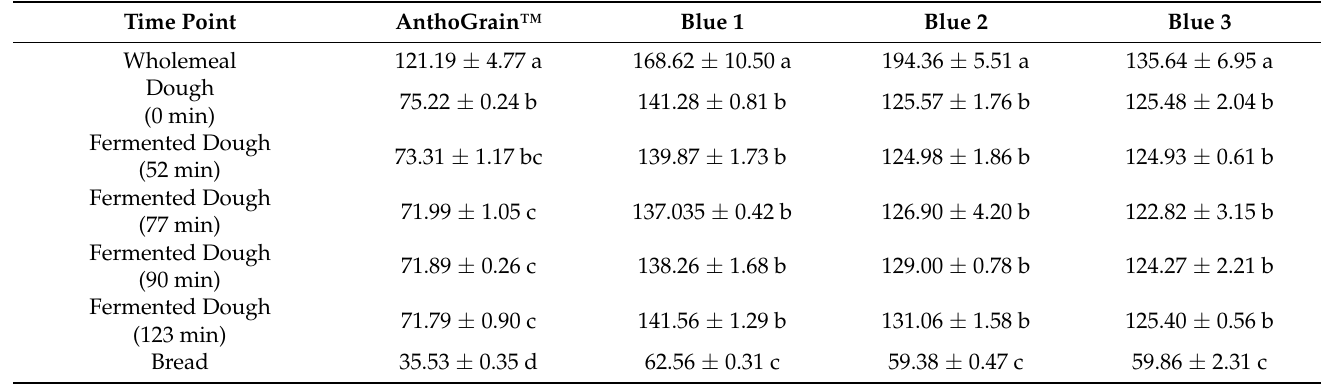
(Table 5). Again, anthocyanin losses were different in the intermediate stages of breads prepared with purple and blue wholemeal. Table 4. Total anthocyanin content (mg anthocyanin/kg wholemeal) of AnthoGrain™ and Blue